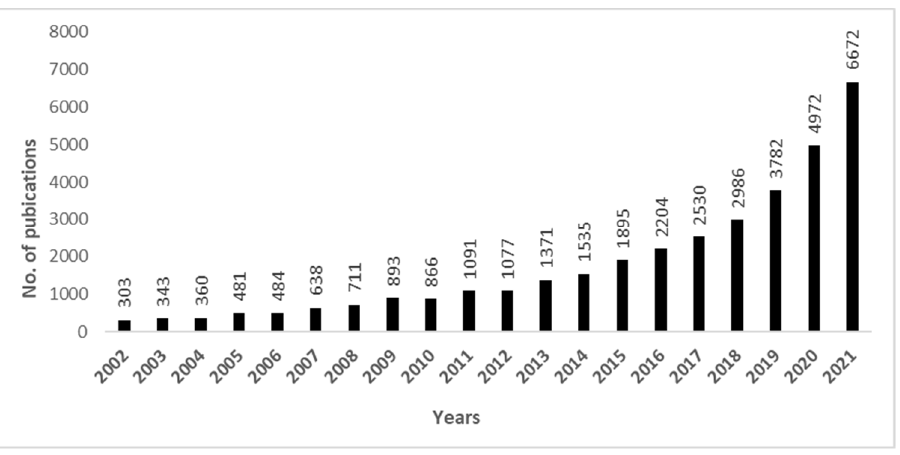
Figure 1. Publications on nanocellulose regarding wastewater treatment over the last twenty years (ScienceDirect database).